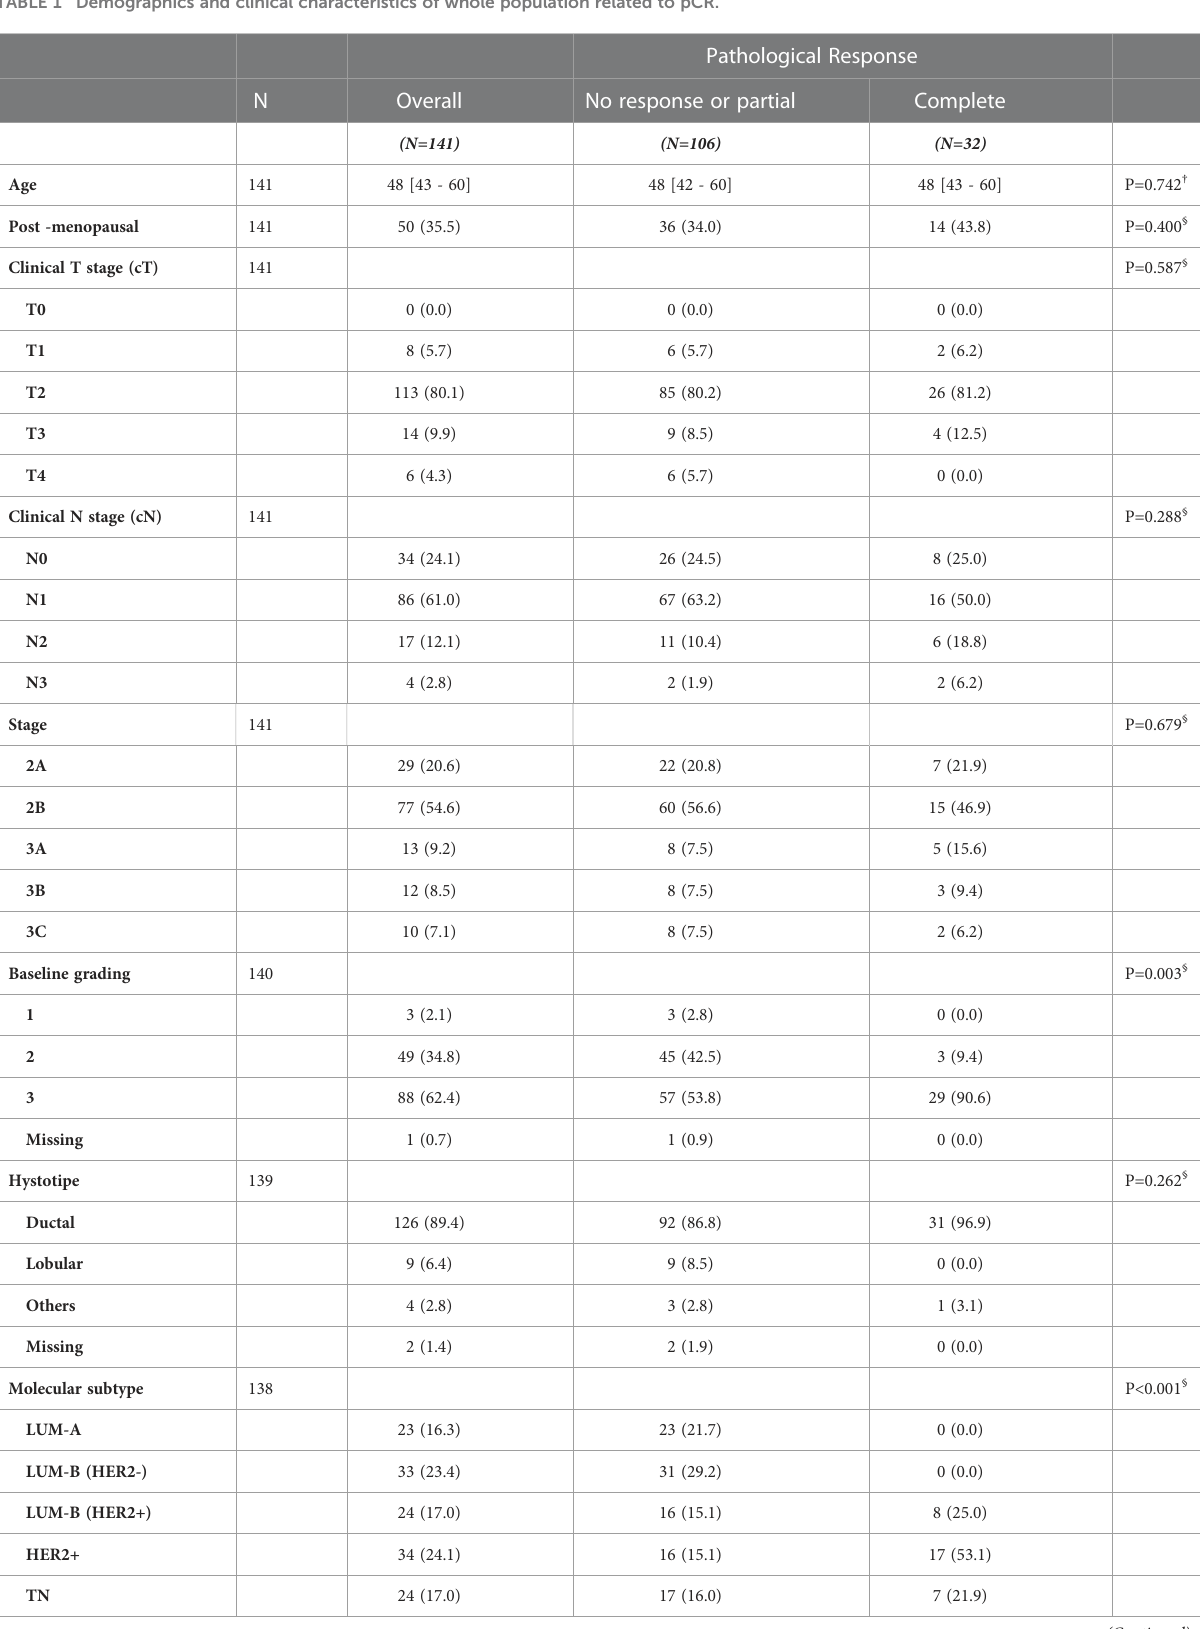
TABLE 1 Demographics and clinical characteristics of whole population related to